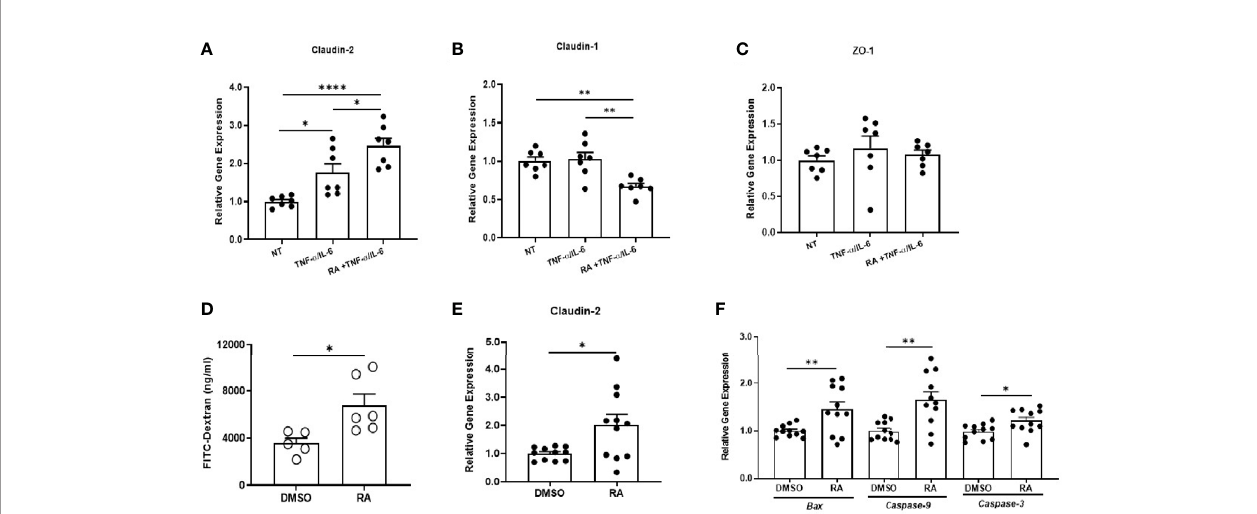
FIGURE 1 | Retinoic acid increases gut permeability of recipient mice after allogeneic BMT. Caco-2 cells were maintained for 14 – 21 days and allowed to differentiate. The cultures were then treated with either DMSO or 5 µM RA for 4 days. They were exposed to TNF- a (20 ng/ml) and IL-6 (20 ng/ml) during the last 24 hours of incubation. Culture wells that did not receive any treatments were used as controls. Gene expression of Claudin-2 (A) , Claudin-1 (B) , and ZO-1 (C) from different treatment groups was analyzed by real-time q-PCR. Data are normalized for b 2 ‐ microglobulin RNA and presented as fold increase over gene expression in no treatment (NT) group. Data are shown as Mean ± SEM and are cumulative results from two independent experiments. (D – F) Lethally irradiated Balb/c mice were transplanted with 7 x10 6 BM plus 0.4 x 10 6 puri fi ed T cells from B6 mice. Recipient mice then received intraperitoneal injections of either DMSO or 450 µg of RA every other day for 4 doses. On Day 7 post-BMT, FITC-dextran analysis was performed, and colonic epithelium was collected for real-time q-PCR analysis. (D) Serum levels of FITC-dextran in recipient mice (n = 5 – 6 per group). (E, F) Relative gene expression of Claudin-2 and apoptotic markers (n = 11 per group). Data are shown as Mean ± SEM and are cumulative results from two to three independent experiments. Statistics: * P ≤ .05, ** P ≤ .01, **** P ≤